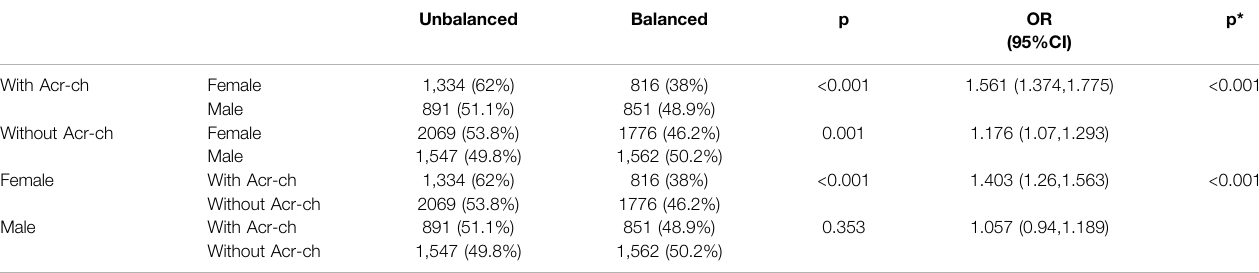
TABLE 3 | Analysis of balanced and unbalanced segregation patterns according to carrier sex and chromosome